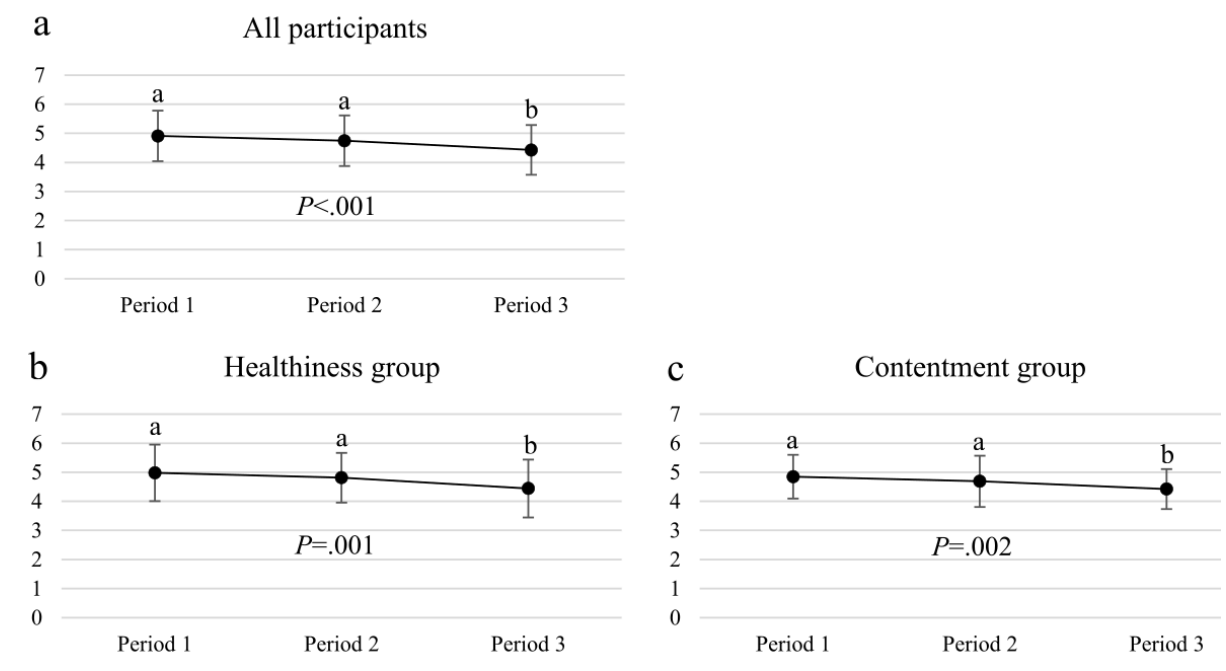
Figure 4. Average number of reported eating occasions per day (mean ± SD) in the three periods (Period 1 = days 1-10, Period 2 = days 11-20, Period 3 = days 21-30) in a) all participants (n=59) and members of b) Healthiness group (n=29) and c) Contentment group (n=30). Different superscript letters indicate a statistically significant difference between study